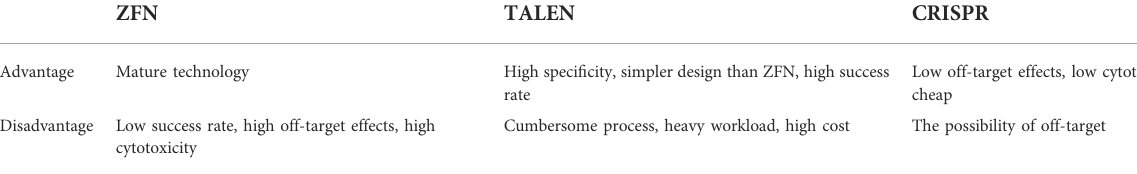
TABLE 4 The advantage and disadvantages of the three main used gene editing